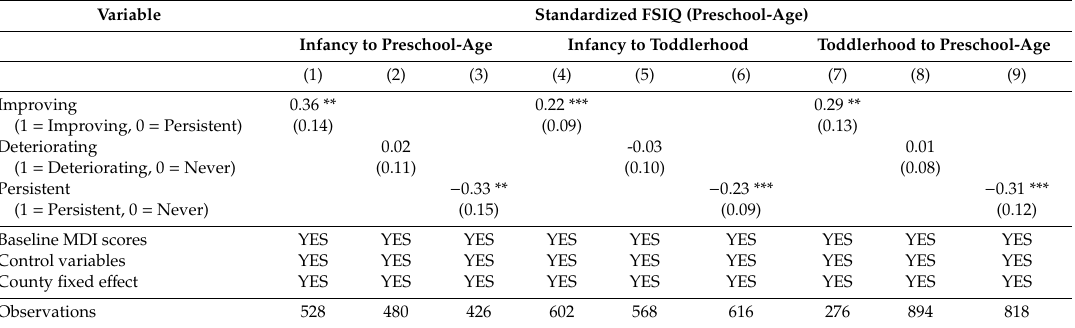
Table 4. Di ff erences cognitive outcomes between anemia